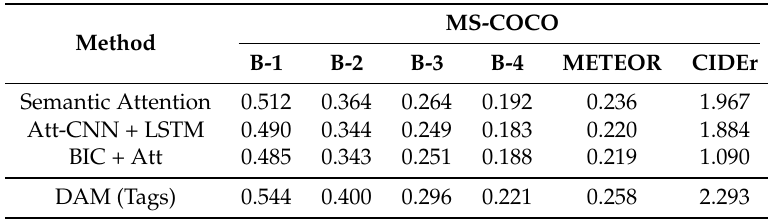
Table 3. Comparisons by using man-made user tags with the modified evaluation